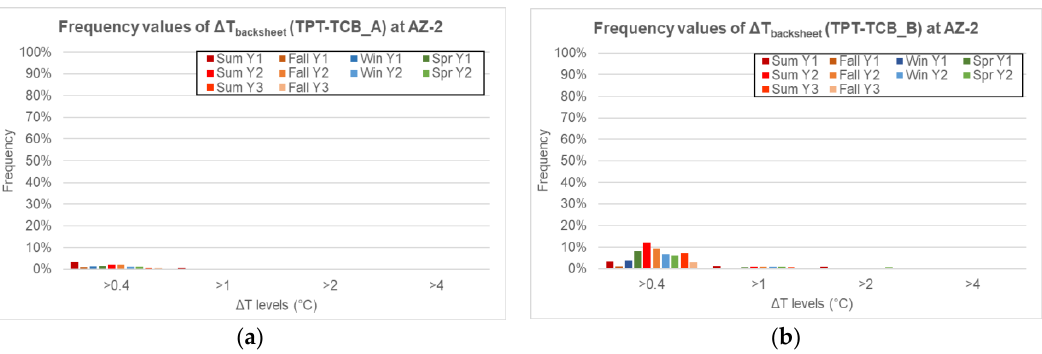
Figure 7. Frequency percentage of ΔT backsheet seasonal trends indicating values of >0.4 °C, >1 °C, >2 °C and >4 °C over 10 seasons/two and a half years from summer (Sum Y1) to fall (Fall Y3) in one-cell modules were installed at the AZ-2 site. ( a ) TPT- TCB_A and ( b ) TPT-TCB_B.